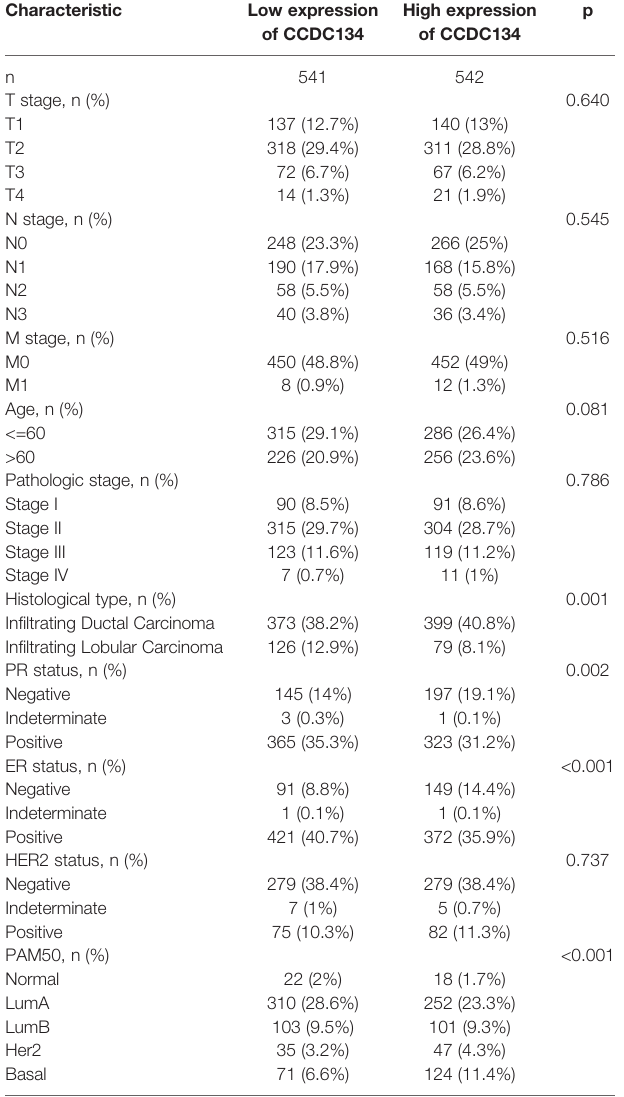
TABLE 1 | Clinical characteristics of the Breast invasive carcinoma patients (TCGA).